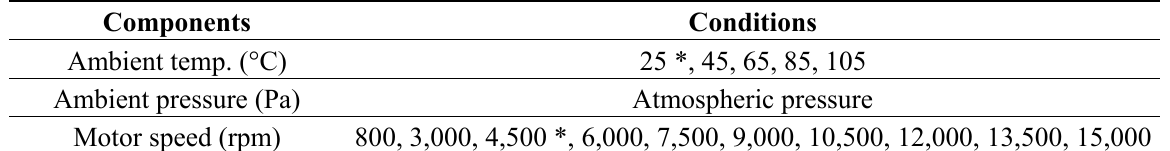
Table 3. Boundary